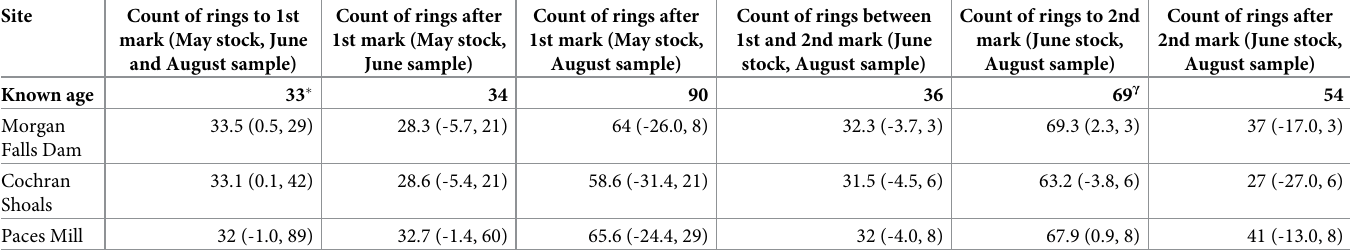
Paces Mill Measurement error in days and the sample sizes are listed in